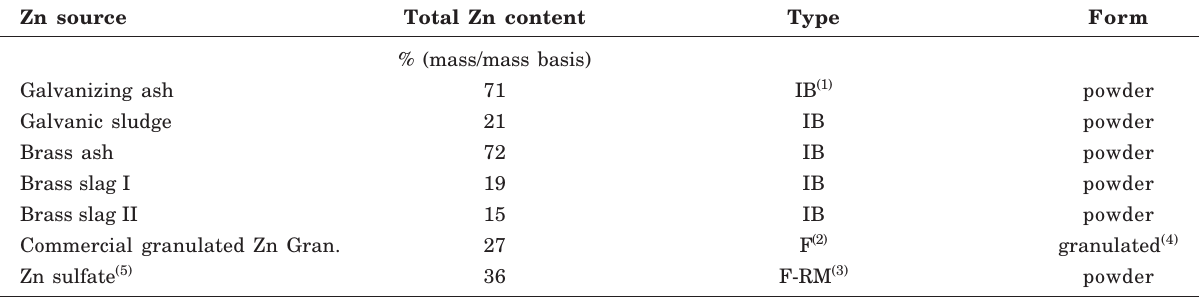
(1) IB: industrial by-products with potential for use as raw material in fertilizer production. (2) F: fertilizer registered and available on the market. (3) F-RM: material which can be marketed as raw material and as fertilizer. (4) Fertilizer granulated with sulfuric acid at processing. (5) Sample dried in a